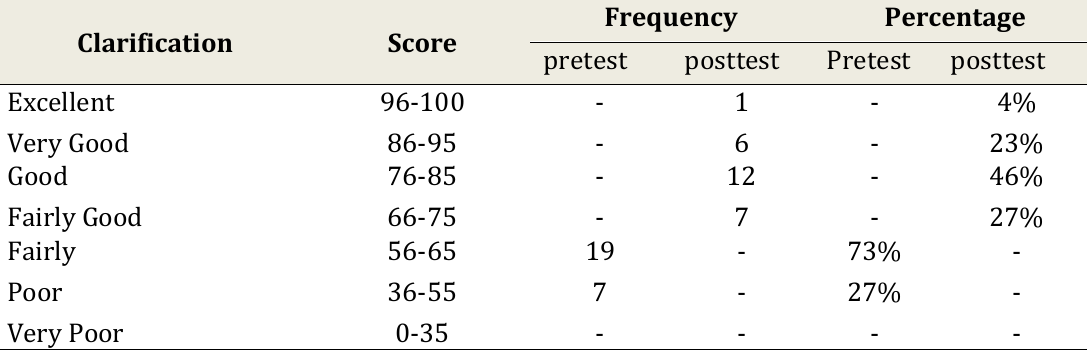
Table 4.2 The students’ percentage in pretest and post -test